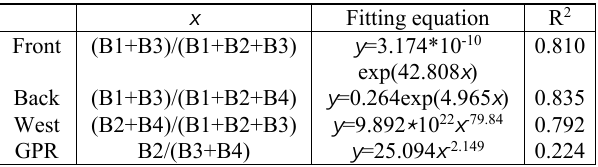
Table 4. The SPM regression models of GPR channels based on